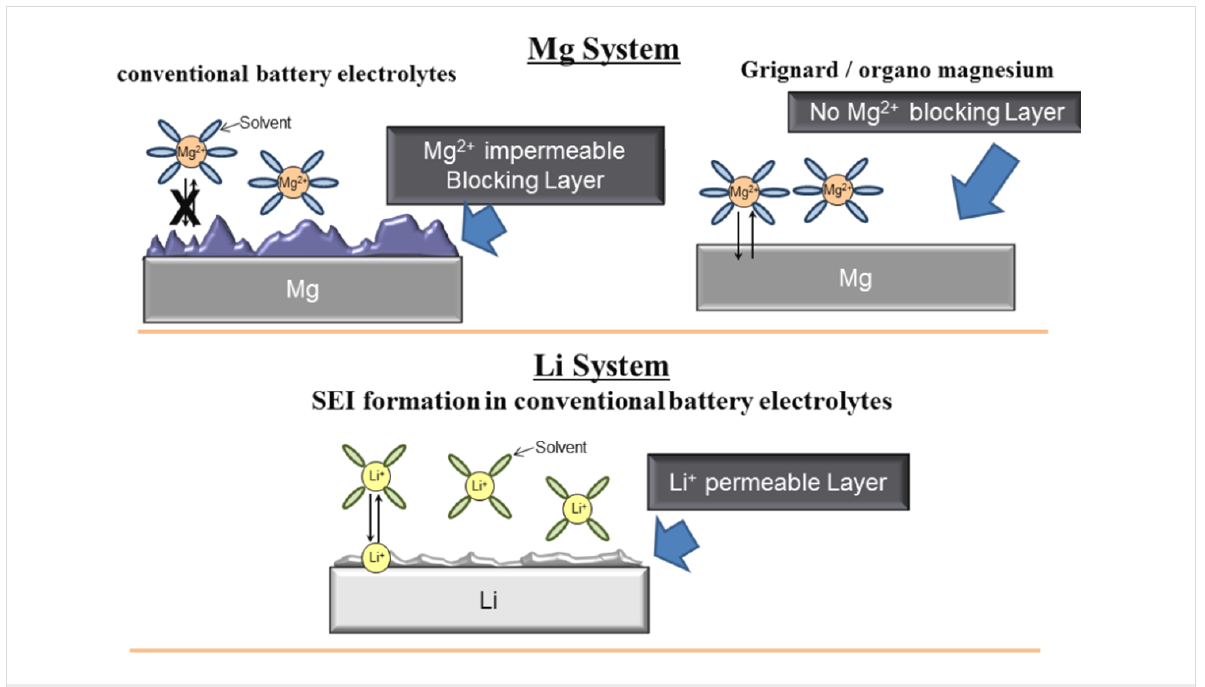
Figure 1: Schematic depicting a simplified image of metal–electrolyte interfaces for magnesium and lithium metals. The magnesium metal case; unlike the lithium, experiences a blocking layer formation when exposed to conventional electrolytes, i.e., ionic salts and polar solvents. No Mg passi- vation (bare Mg) occurs in ethereal organo-magnesium